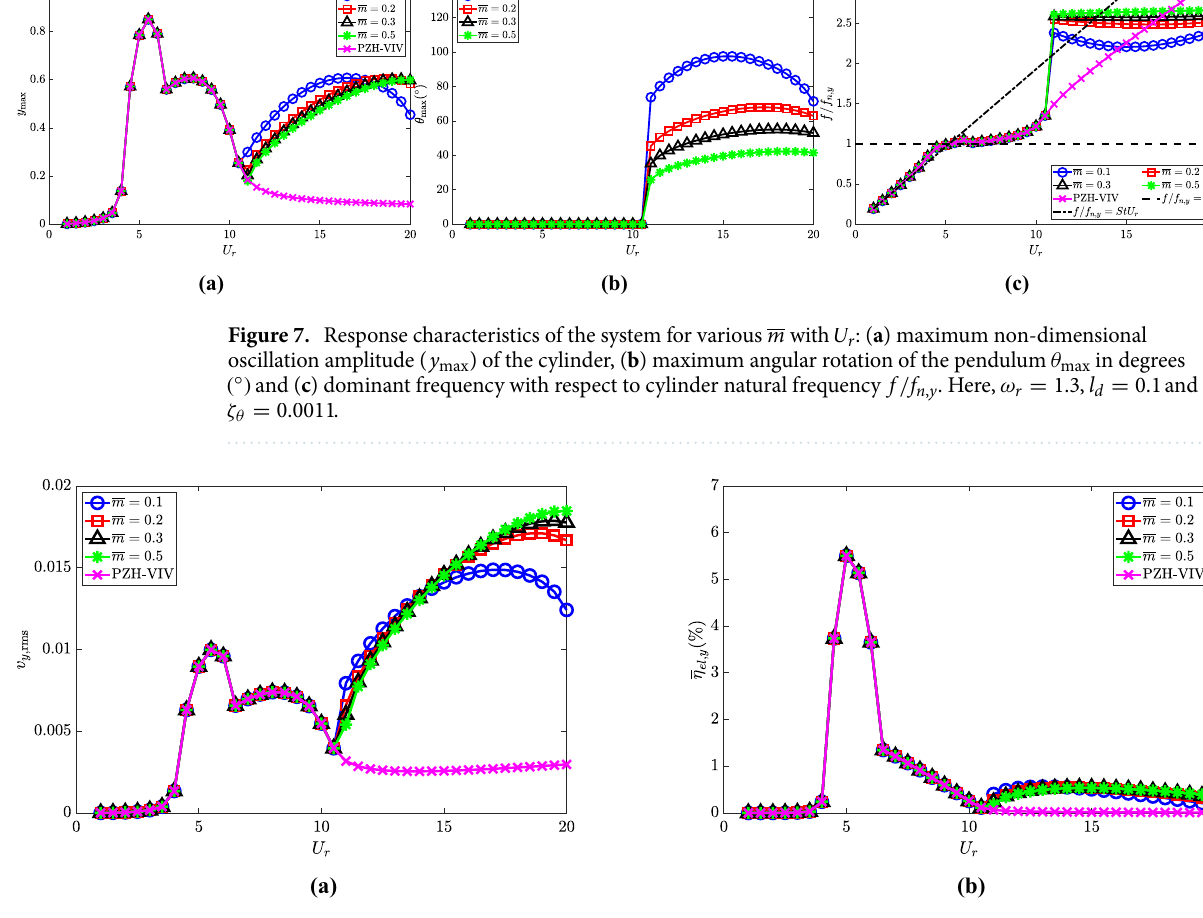
Figure 8. Effect of m in the introduction of NRGP with U r on: ( a ) electric tension v y ,rms , and ( b ) energy harvesting efficiency η el , y . Here, ω r = 1.3 , l d = 0.1 and ζ θ = 0.0011